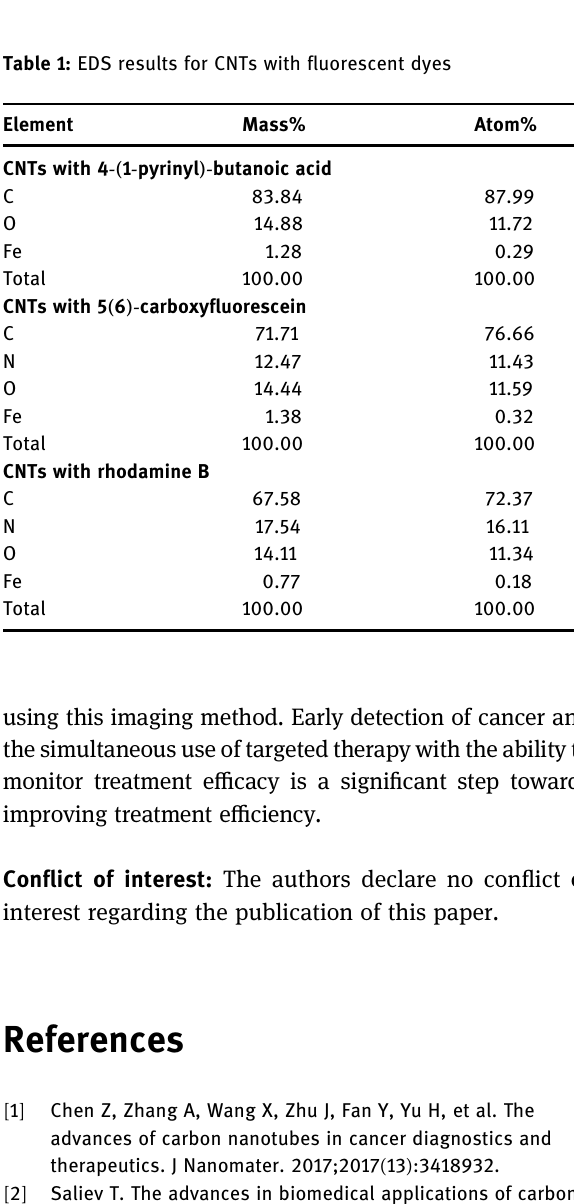
Figure 13: SEM images ( magni fi cation × 2,500 ) for CNTs after acylation with fl uorescent dyes: ( a ) 4 -( 1 - pyrinyl )- butanoic acid; ( b ) 5 ( 6 )- carboxy fl uorescein; ( c ) rhodamine B.